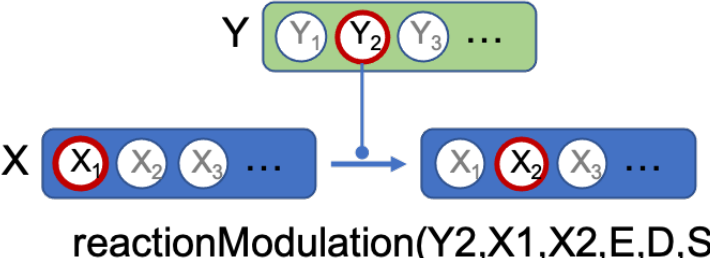
Figure 3. Predicate formalizing the fact that state Y 2 of component Y has effect E on the transition from state X 1 to state X 2 of component X , with distance D and status S